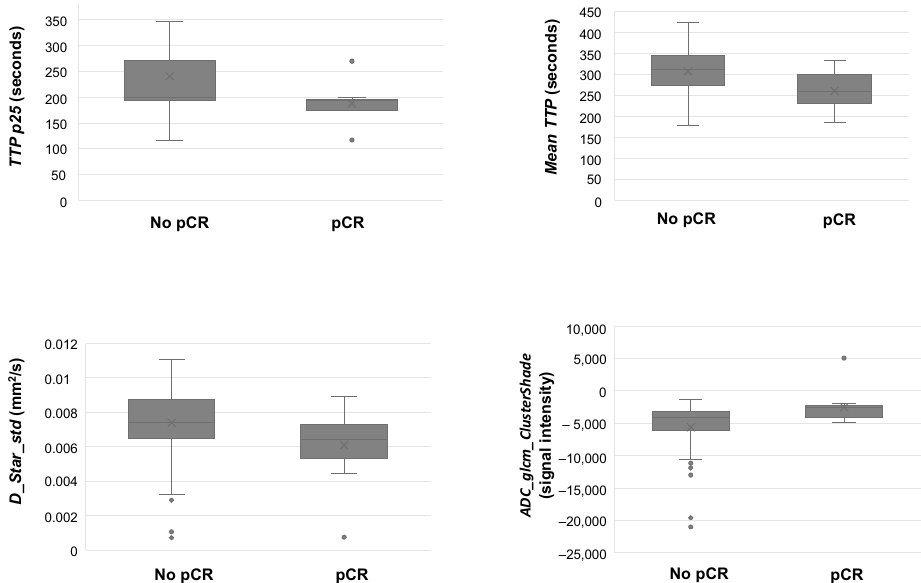
Figure 1. Box-and-whisker plots comparing imaging feature values between patients showing pathological complete response and non-responders.